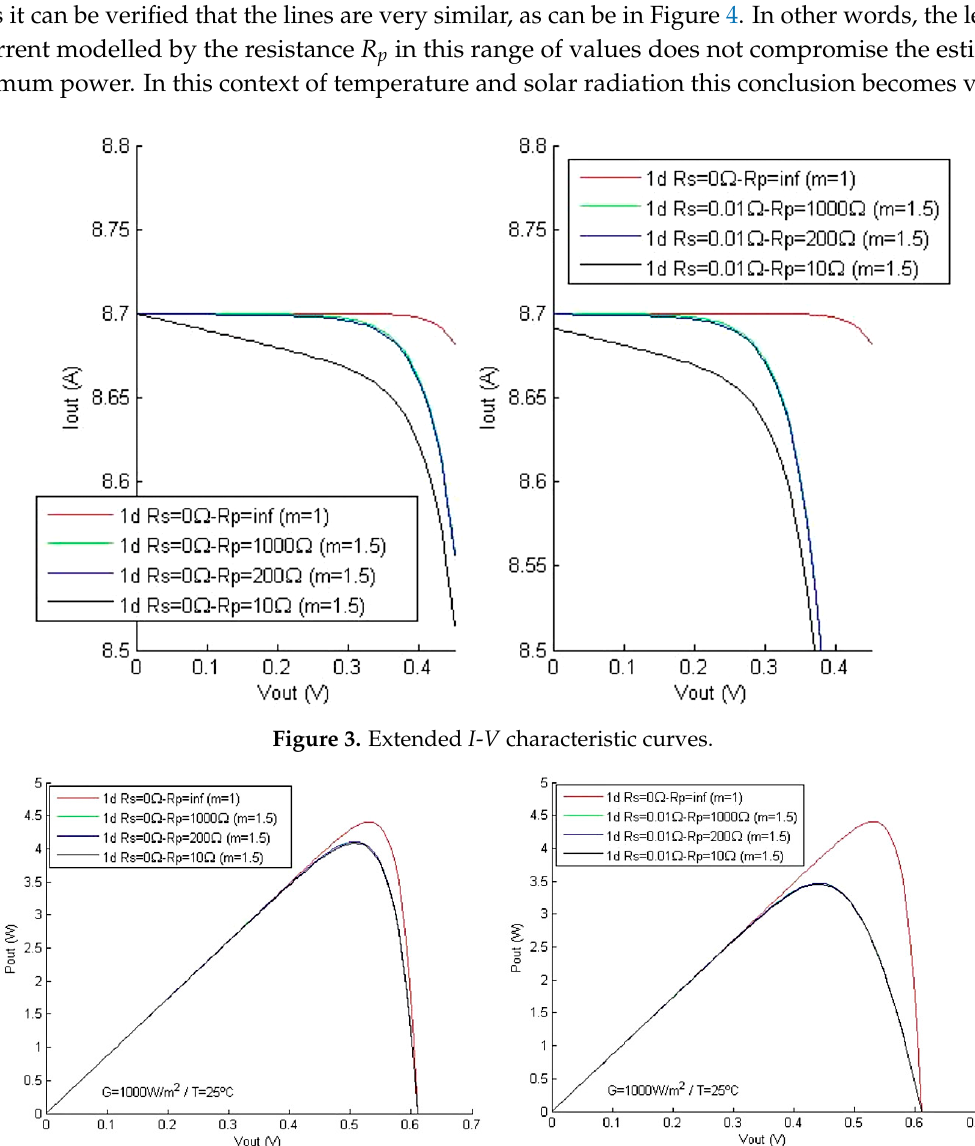
Figure 5. Characteristic curves in function of temperature and parallel resistance R p , with a constant resistance R s (G = 1000 W/m 2 ).